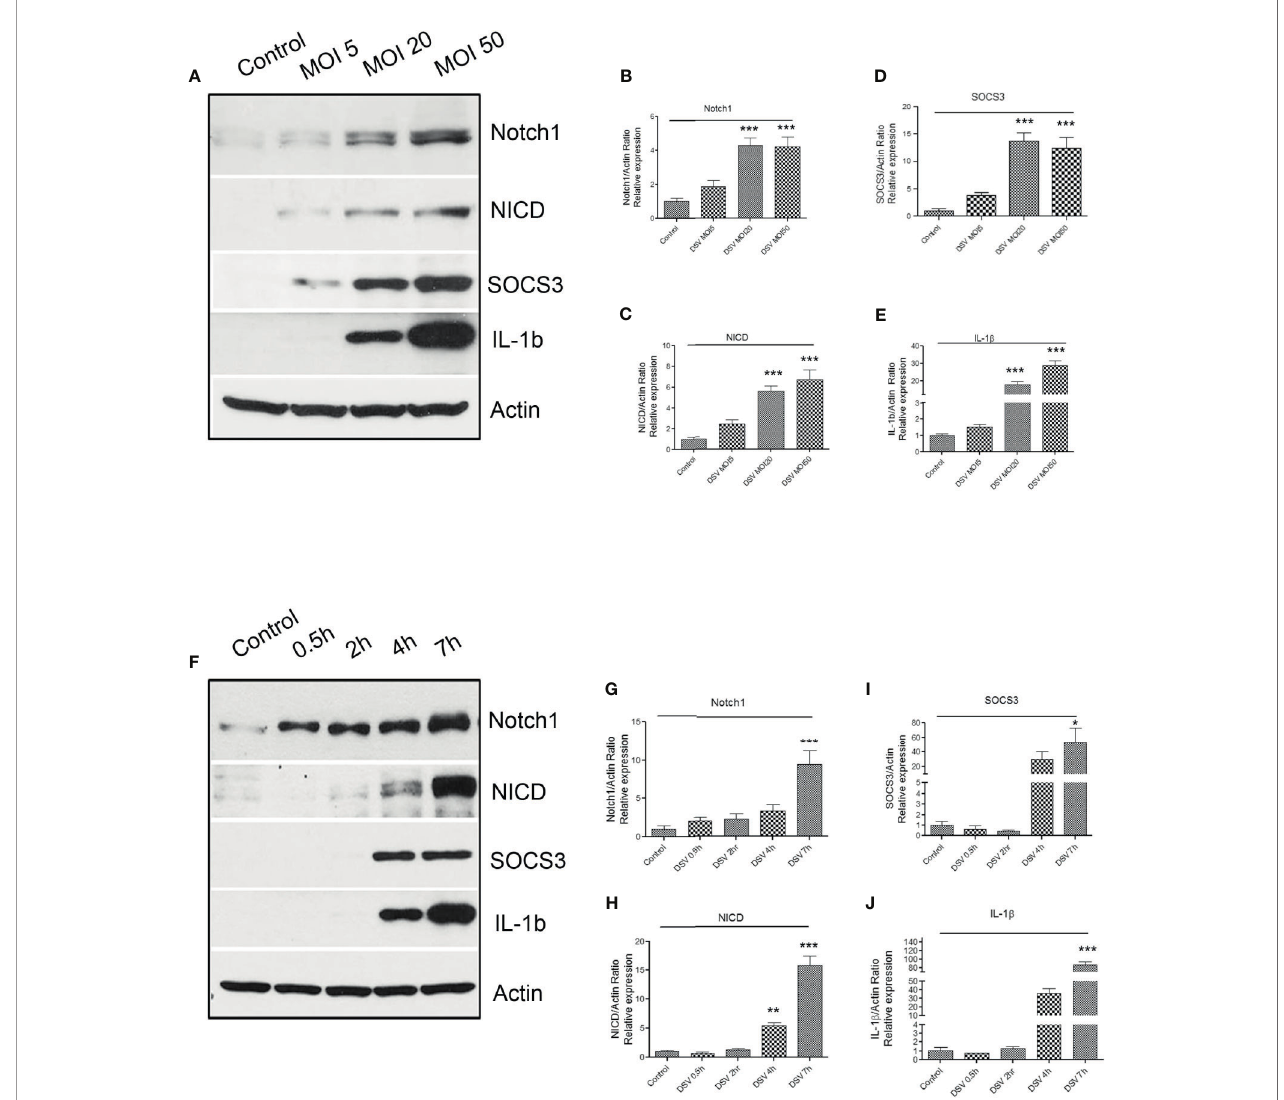
FIGURE 1 | DSV induces dose and time-dependent activation of Notch1 signaling markers, SOCS3, and pro-IL-1 b expression (A) RAW cells (8x10 5 ) were infected with DSV at MOI 5, 20 or 50 for 7 hours. Cells were lysed and protein lysate was prepared. Fifty m g of protein lysate was separated on SDS-PAGE and analyzed for Notch1, NICD, SOCS3, and IL-1 b by Western blotting. Actin was used as a loading control. (B – E) Quanti fi cation of Western blots. Blots were quanti fi ed with ImageJ by analyzing the ratio of protein of interest/Actin. Data represents Mean ± SEM from at least three independent experiments. Values were normalized to control. (F) Cells were infected with DSV (MOI 20) for 0.5, 2, 4, and 7 hours. Fifty m g of protein lysate was separated on SDS-PAGE and analyzed for Notch1, NICD, SOCS3, and IL-1 b by Western blotting. Actin was used as a loading control. (G – J) Quanti fi cation of Western blots. Blots were quanti fi ed with ImageJ by analyzing the ratio of protein of interest/Actin. Values were normalized to control. Data represents Mean ± SEM from at least three independent experiments. One-way ANOVA was used to determine the statistical signi fi cance. Values were compared to control, with a post-hoc Dunnett ’ s test. *p < 0.05, **p < 0.01, ***p <